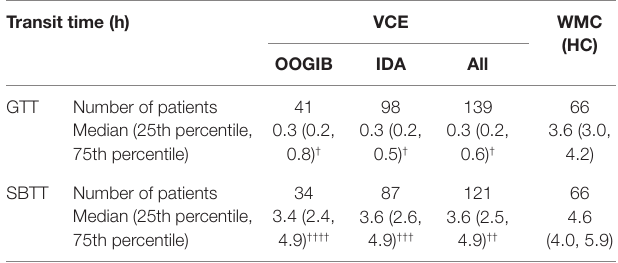
(WMc) historical values retrieved from a study by sarosiek et al.